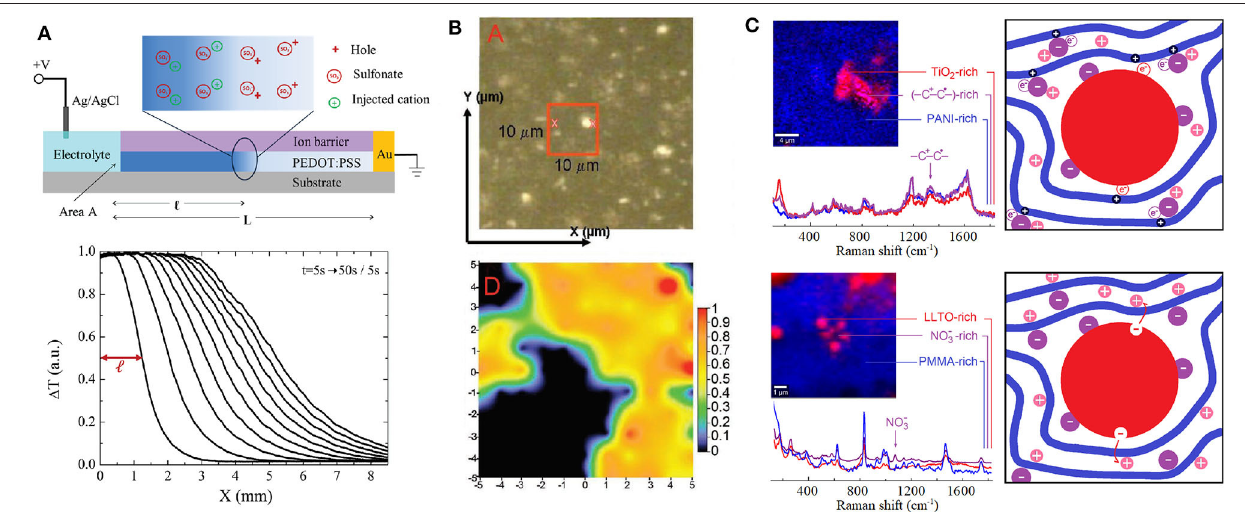
FIGURE 1 | (A) Schematization indicating the charge distribution around the dedoping front (upper panel) and evolution of dedoping front where 1 T is the change of transmitted light intensity with respect to the zero bias state during the injection of potassium cations for PEDOT:PSS film (lower panel) (Stavrinidou et al., 2013). This figure was used and adapted/altered minimally with permission from John Wiley and Sons. (B) Optical image (upper panel) and Raman imaging (lower panel) providing a semi-quantitative measure of the Li 1 − x (Ni y Co z Al 1 − y − z )O 2 (NCA) cathode state of charge (SOC) where the dark region is associated to carbon-rich zone and the colored region is associated to the NCA-rich zone ranging from blue (lower SOC) to red (higher SOC) (Nanda et al., 2011). This figure was used and adapted/altered minimally with permission from John Wiley and Sons. (C) Raman imaging and schematization of charge carrier localization near hybrid organic–inorganic interphases for electronic conducting polymer nanocomposite (sulfonic acid-doped polyaniline with embedded TiO 2 nanoparticles; Mombrú et al., 2017a) (upper panel) and ionic conducting polymer nanocomposite (lithium nitrate solid polymethylmethacrylate electrolyte with embedded Li 0.3 La 0.7 TiO 3 nanoparticles; Romero et al., 2016) (lower panel). References for schematization are as follows: organic polymer (blue), inorganic nanoparticles (red), dopant cation ( + , in pink), dopant anion (–, in purple), and electronic charge carriers ( + , in dark blue). Micro-Raman images and spectra are portions of figures adapted/altered minimally with permission from